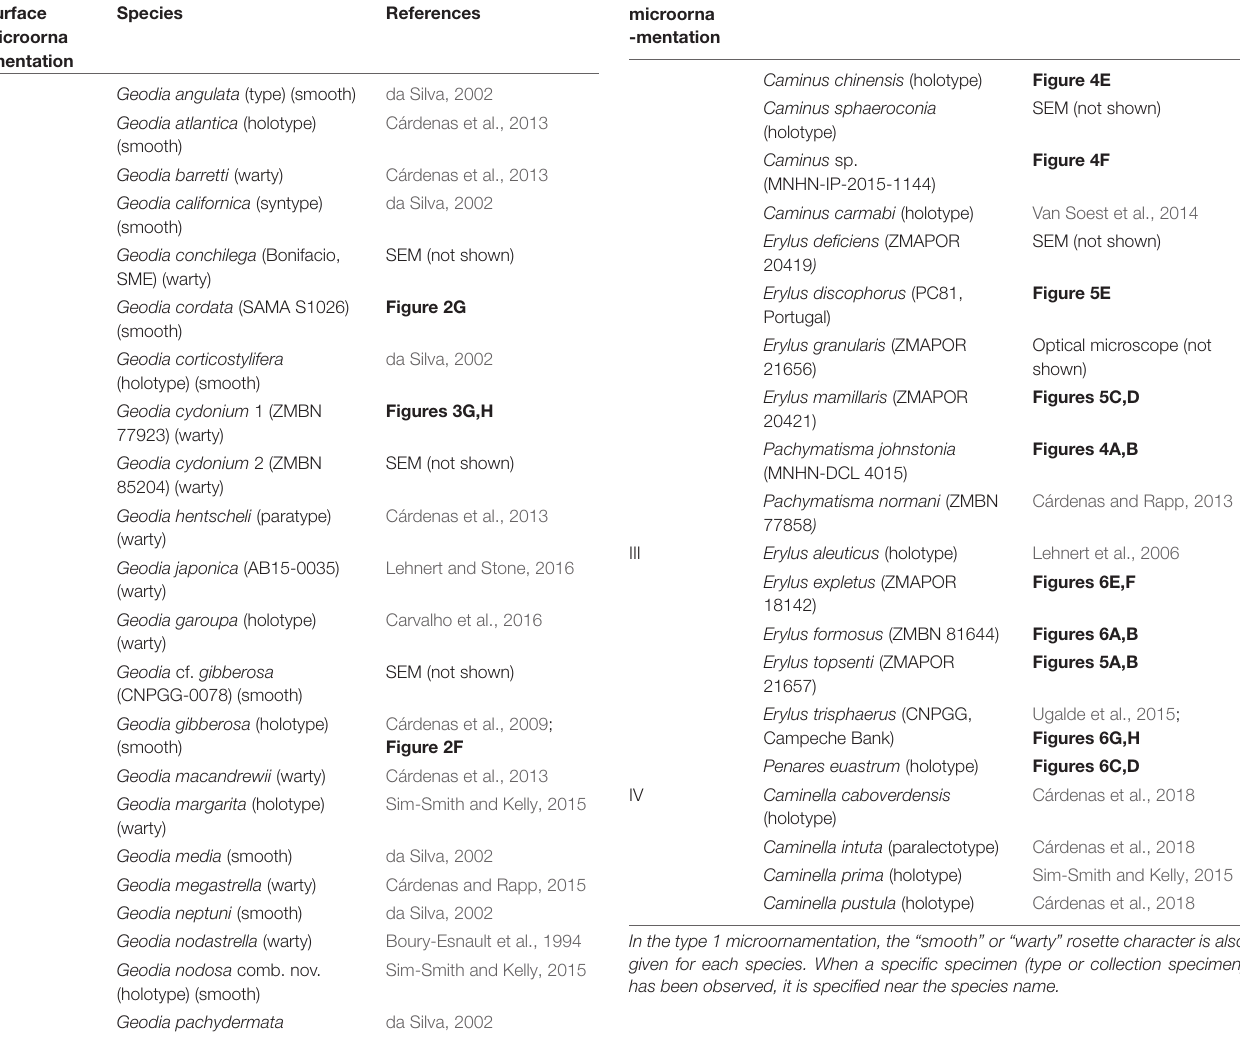
TABLE 3 | Species list for the four types of surface microornamentations (within each type, species are in alphabetical order). Surface microorna -mentation